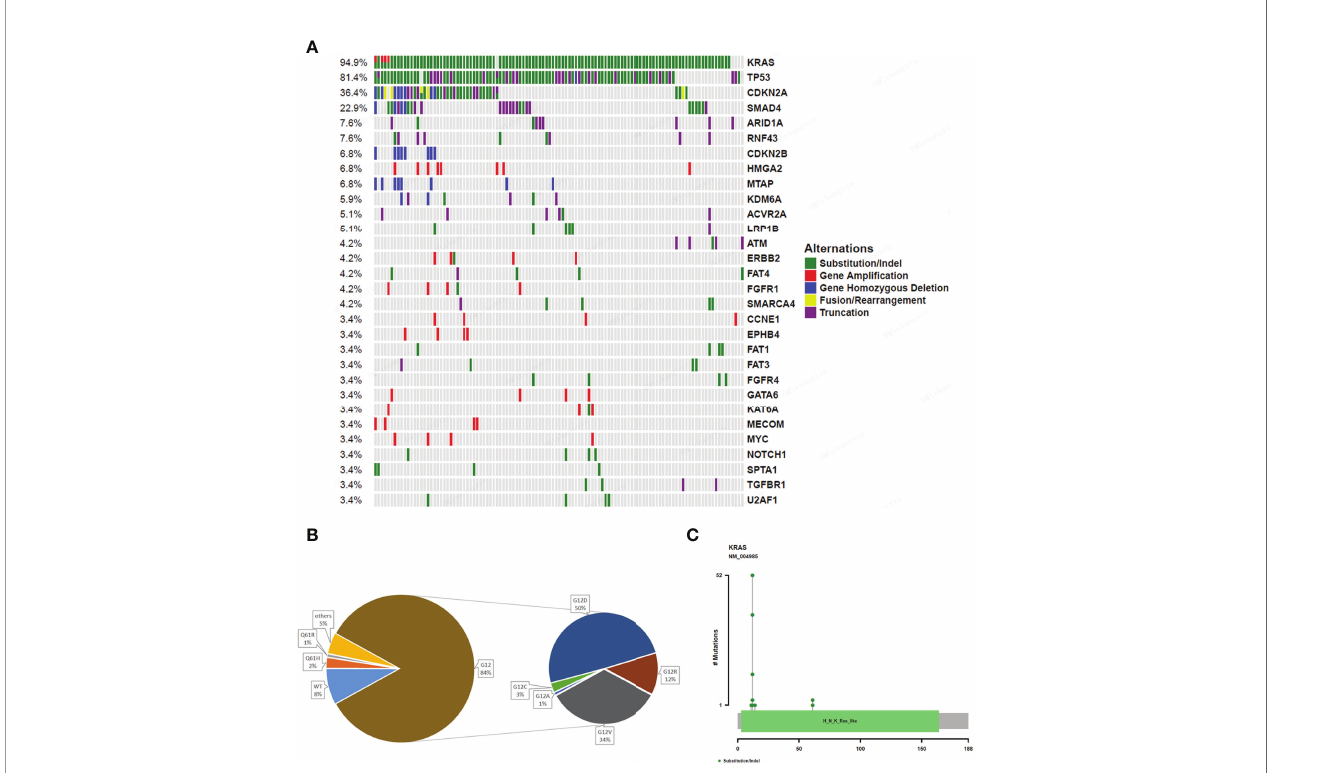
FIGURE 1 | Gene alterations of 118 pancreatic cancer patients. (A) The mutation pro fi les. The panel shows the matrix of mutations with each type of mutation in a different color. Each column denotes an individual tumor and each row represents a gene. The right panel shows the name of mutations and the left panel shows the proportion of mutations. Green; Substitution/Indel, Red; Gene ampli fi cation, Blue; Gene homozygous deletion, Yellow; Fusion/Rearrangement, Purple; Truncation. (B) Ratio of different mutation types in KRAS gene. (C) The distribution map of KRAS gene mutation sites showing the distribution of mutation